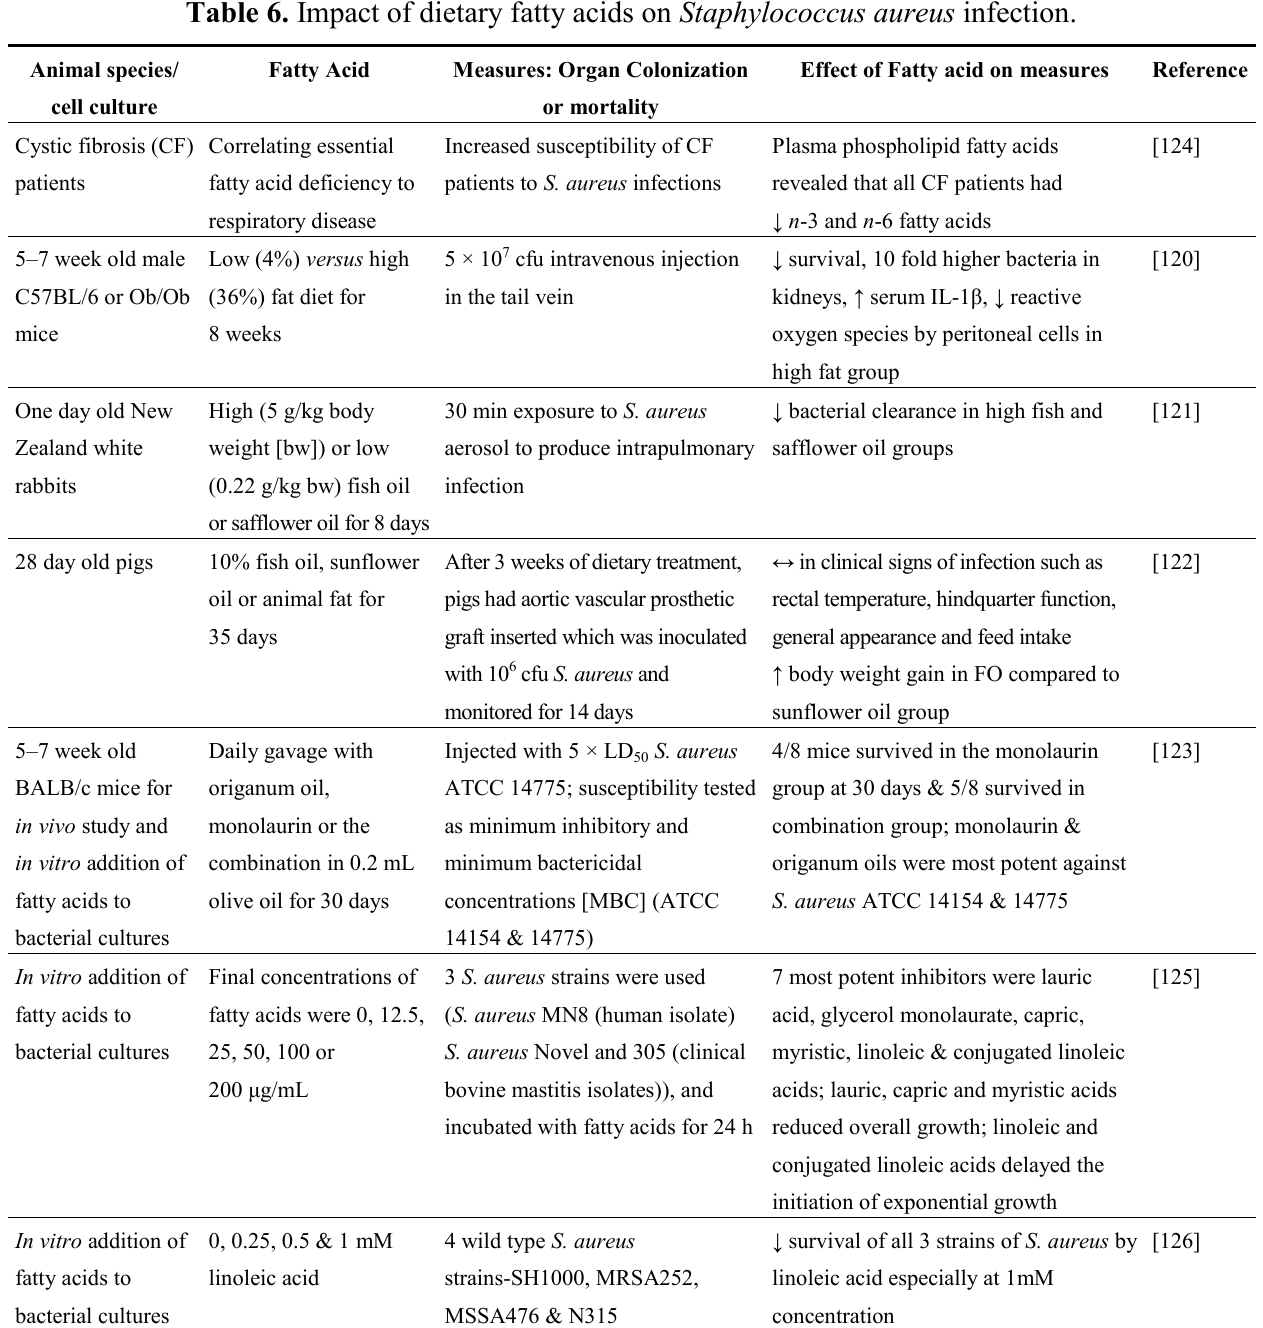
Table 6. Impact of dietary fatty acids on Staphylococcus aureus